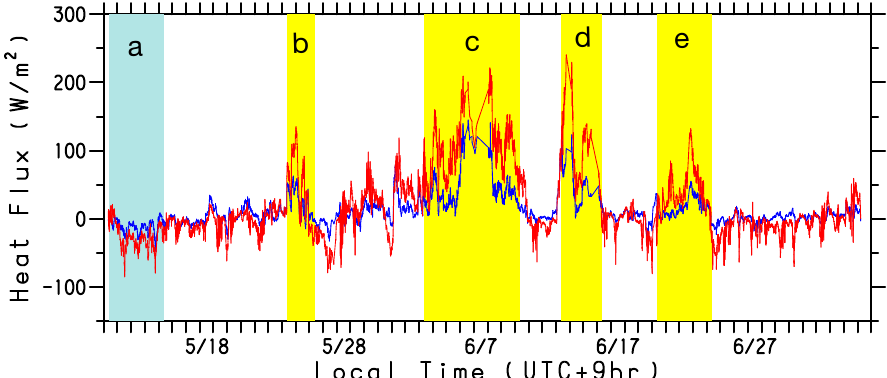
Figure 5. Time series of latent (red line) and sensible (blue line) sea surface heat fluxes (Wm − 2 ) along the WG track. The abscissa is local time (UTC + 9h) during the observation period from 11 May to 5 July 2022. Cyan and yellow bands marked by letters a–e indicate periods during which heat fluxes are shown in